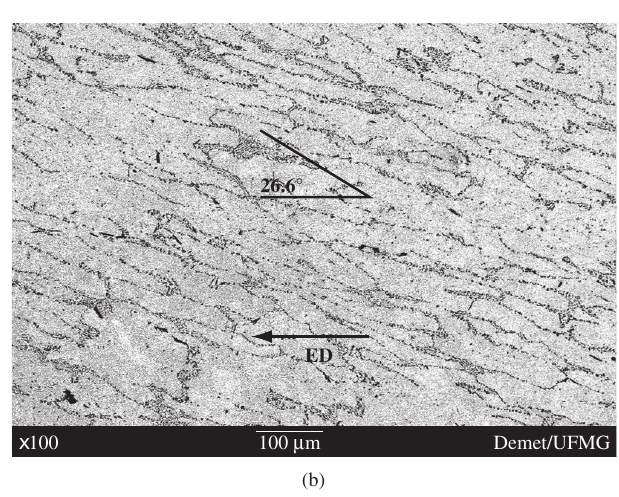
Figure 4. SEM image of Pb-4%Sb alloy processed by one pass of ECAP (cross section).